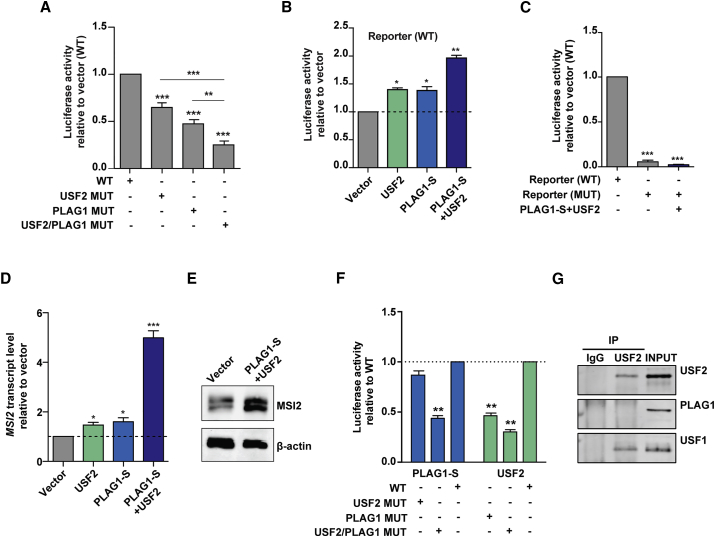
PLAG1-S and USF2 Collaboratively Regulate MSI2 Promoter Activity and MSI2 Expression(A) Reporter activity upon combinatorial binding site mutagenesis for USF2 and PLAG1 within the MSI2 minimal promoter region. n = 11 independent experiments.(B) Reporter construct luciferase activity upon independent or coincident overexpression of USF2 and PLAG1-S (n = 3 experiments).(C) Luciferase activity of PLAG1 and USF2 MUT reporters upon PLAG1-S and USF2 co-overexpression (n = 3 experiments).(D and E) Endogenous MSI2 transcript (D) (n = 3 experiments) and protein levels (E) following overexpression of PLAG1-S and USF2 in K562 cells compared with vector control.(F) Luciferase reporter activity of the MSI2 minimal promoter region upon PLAG1-S or USF2 overexpression when the binding site for the reciprocal factor or for both factors is mutated (MUT) (n = 3 experiments).(G) Co-immunoprecipitation analysis performed on K562 cells using anti-USF2 for immunoprecipitation and immunoblotting with antibodies to USF2, the known USF2 interacting partner USF1 or PLAG1.Data are presented as means ± SEM. ∗p < 0.05, ∗∗p < 0.01, ∗∗∗p < 0.001. See also Table S3.